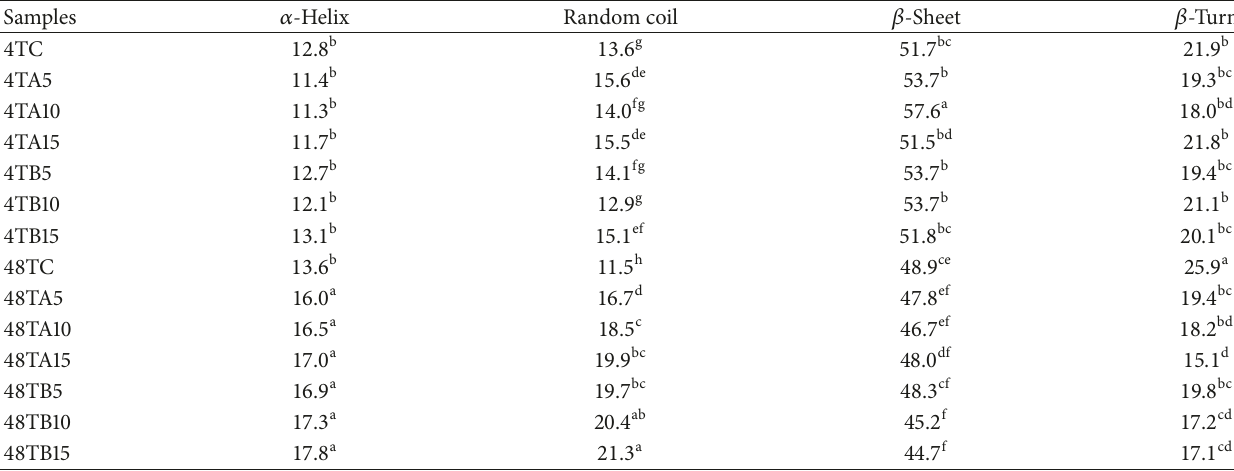
Table 4: The effect of OWP on the secondary structure of gluten as revealed by FT-IR. Data are reported as percentages of total area of amide I